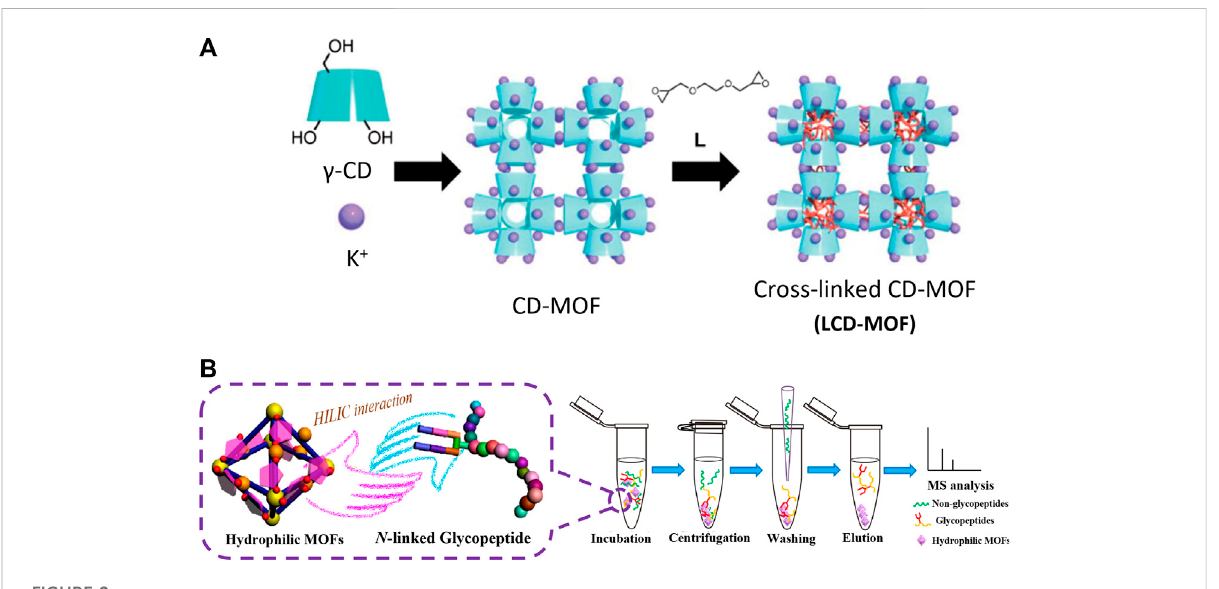
FIGURE 2 (A) Schematic illustration of the synthesis of cubic gel particles. Reproduced from (Furukawa et al., 2012) with permission from John Wiley and Sons. (B) General procedure of N-linked glycopeptide enrichment by hydrophilic MOF. Reproduced from (Peng et al., 2019) with permission from American Chemical